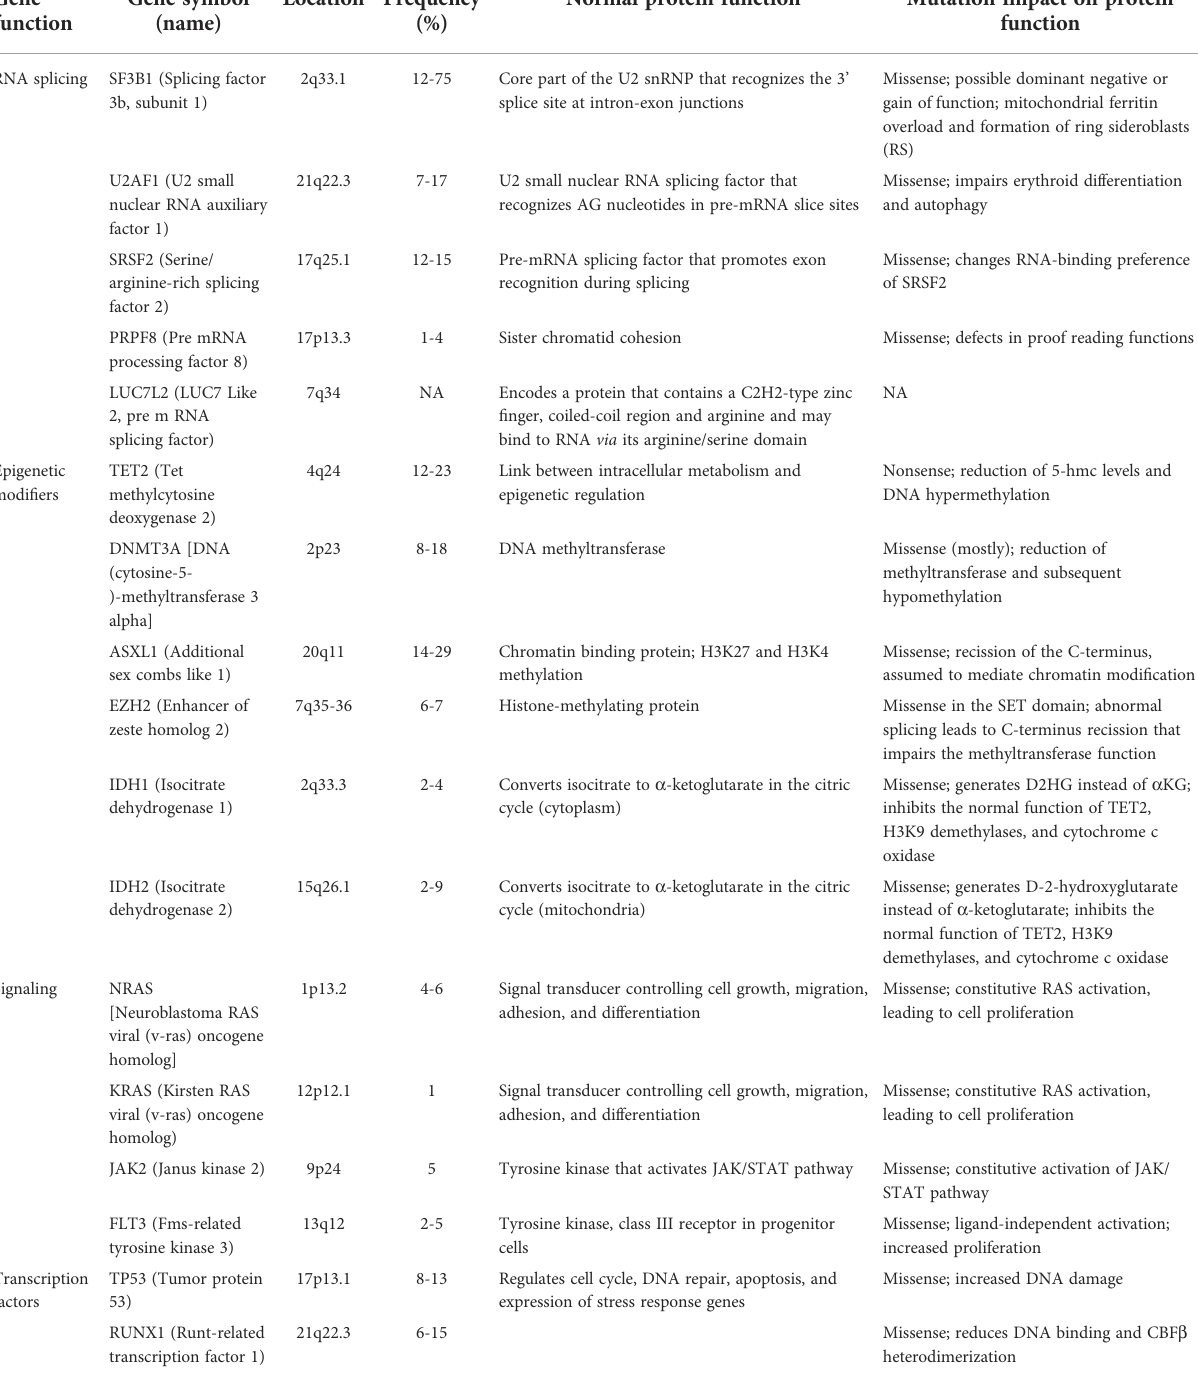
TABLE 1 Somatic mutations in